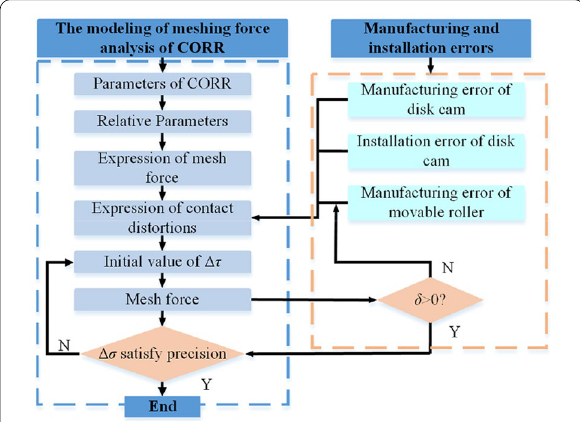
Figure 6 Flow diagram of meshing force